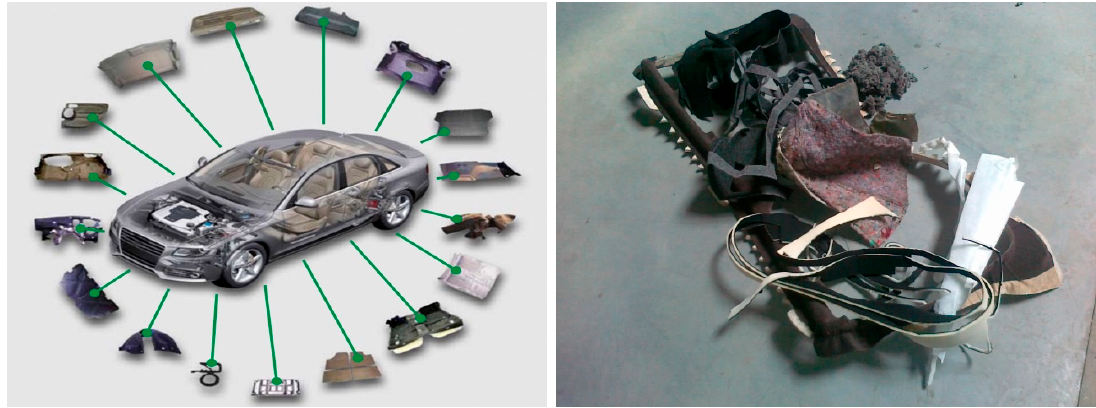
Figure 1. Recycled automobile parts [12].